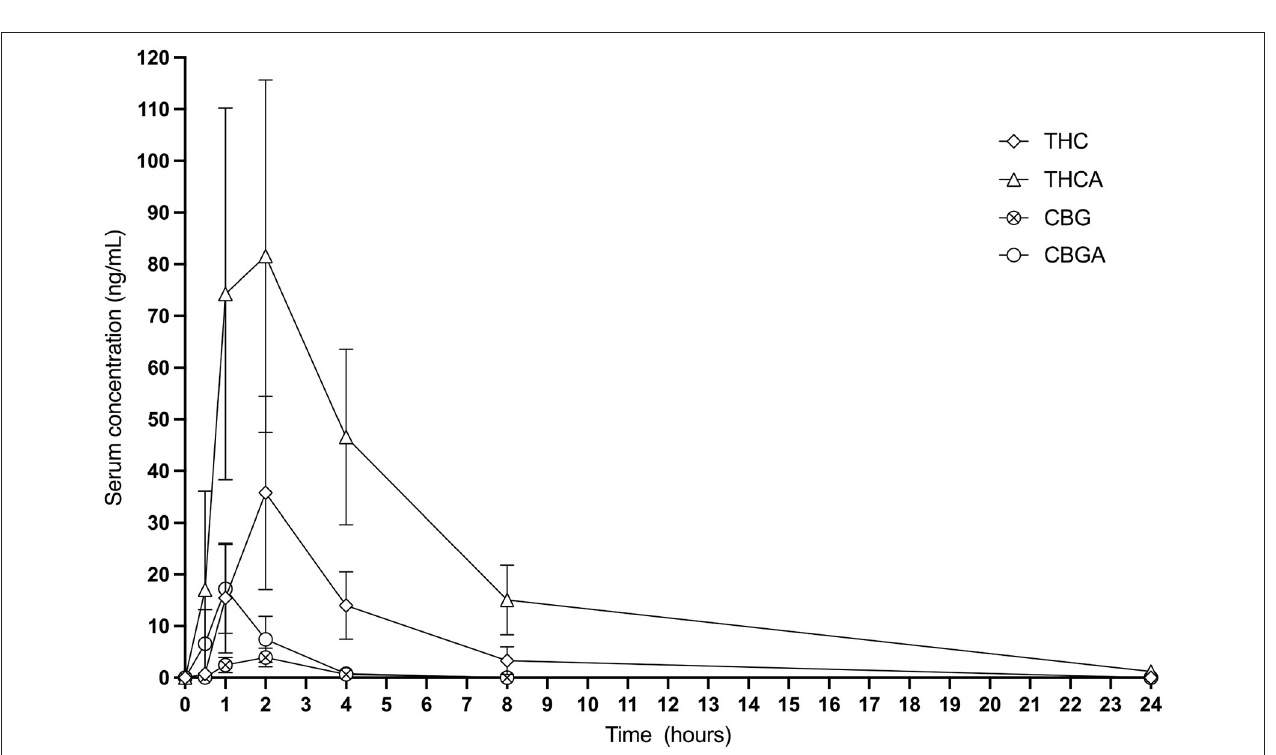
paired Student’s Test was used to assess changes over the week of treatment with a p -value set at <